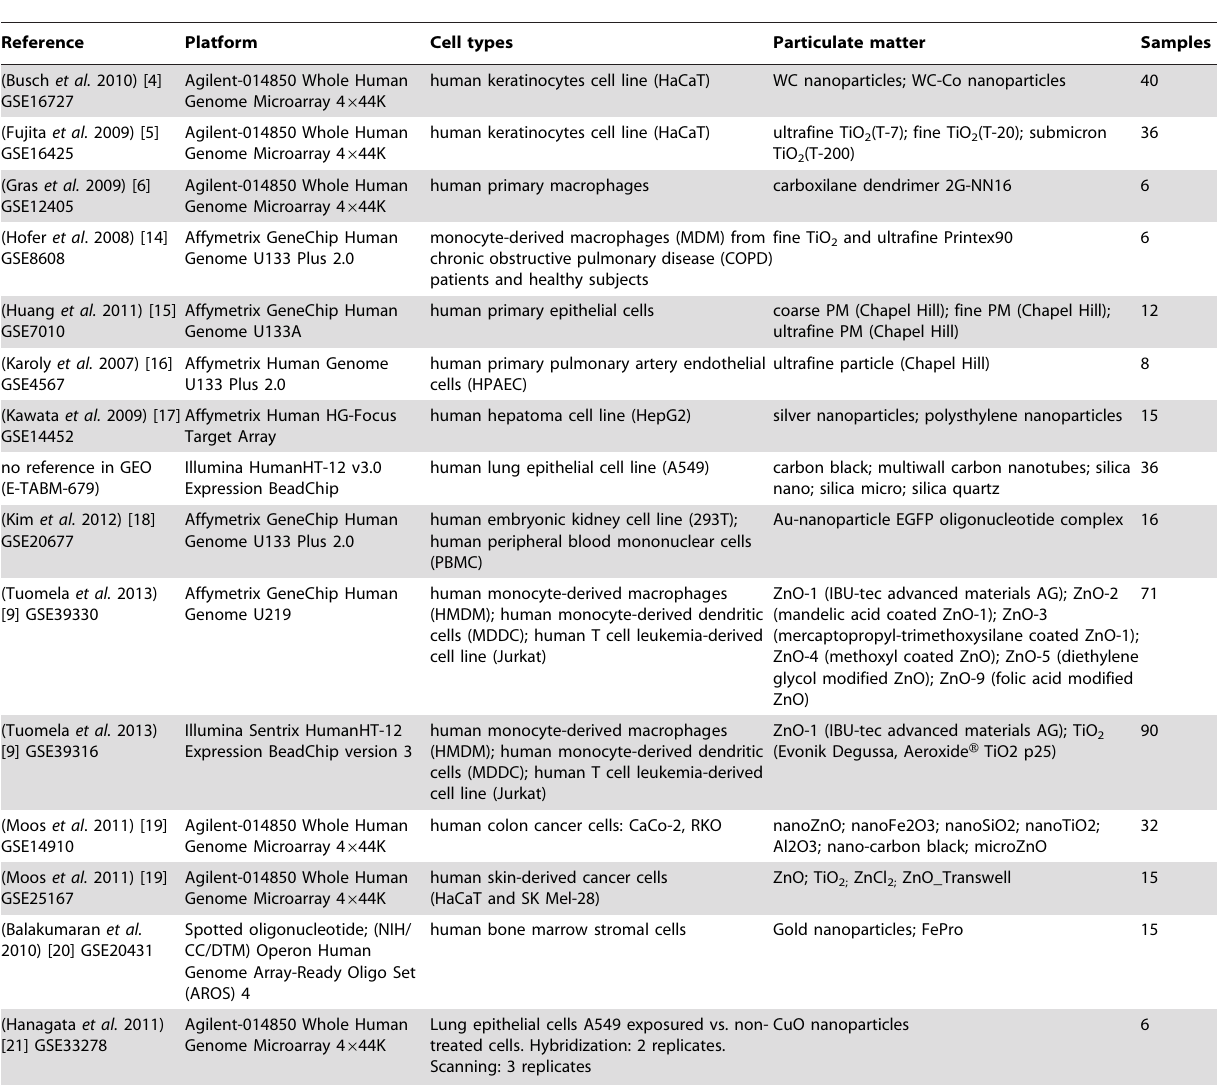
Table 1. The cell types and the particulate matters used in the datasets in NanoMiner.